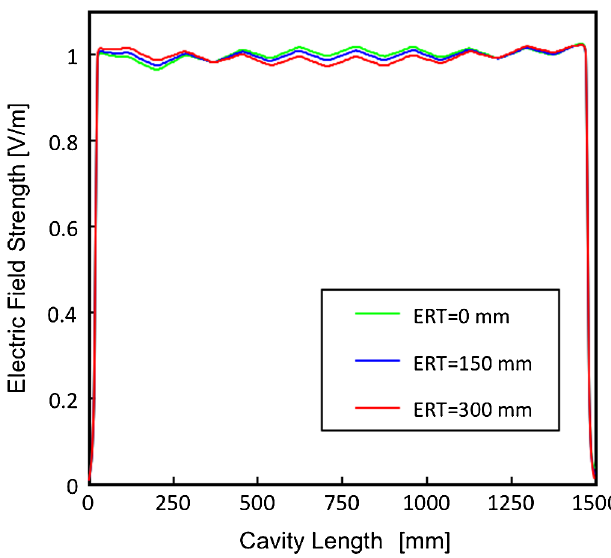
FIG. 4. A resonant cavity design with only two ridges 111 (dimensions are in